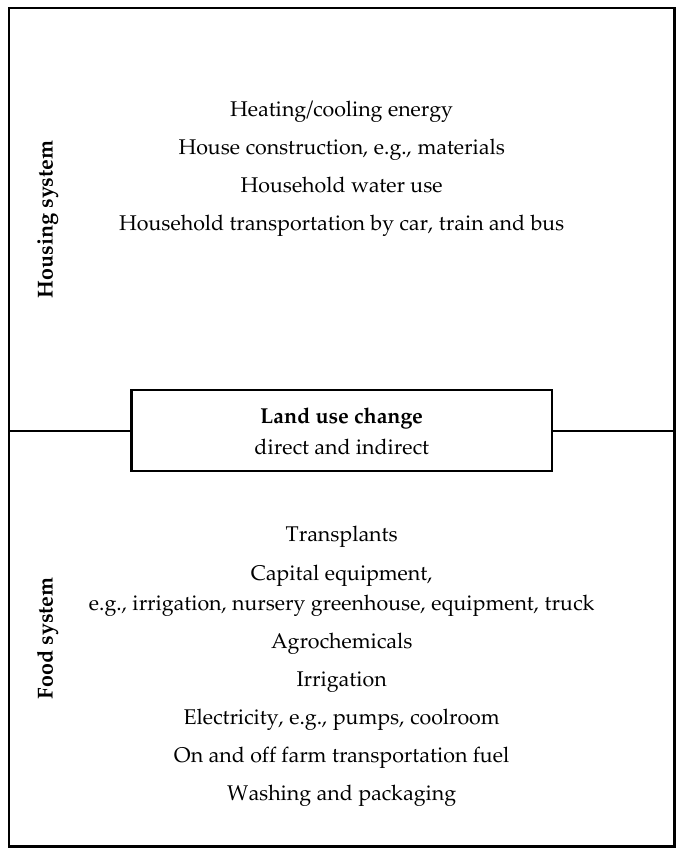
Figure 2. Life cycle inventory (LCI) for the housing and food systems contained within scenarios.